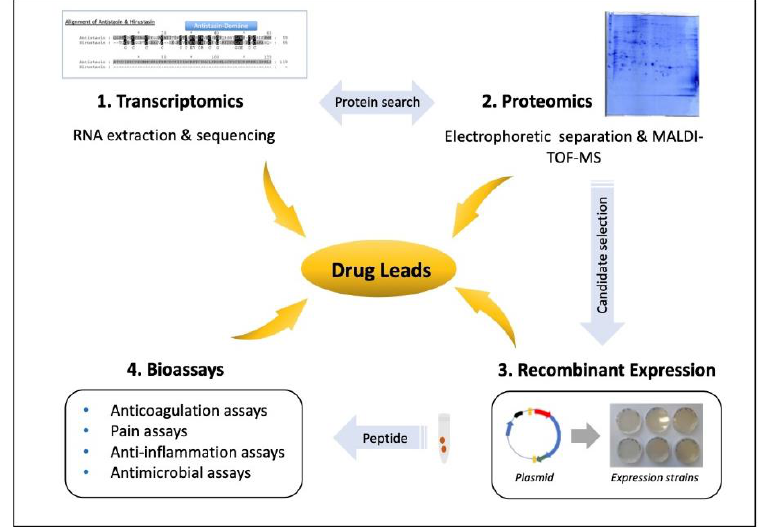
Figure 1. Workflow for the analysis of leech salivary proteins as drug leads. To analyze individual leech salivary proteins, a combination of transcriptomics and proteomics provides the protein sequences. Recombinant proteins are expressed to test their activities in cells, tissues and animal models, for example, to determine whether they possess anticoagulation, analgesic, anti- inflammatory or antimicrobial effects.